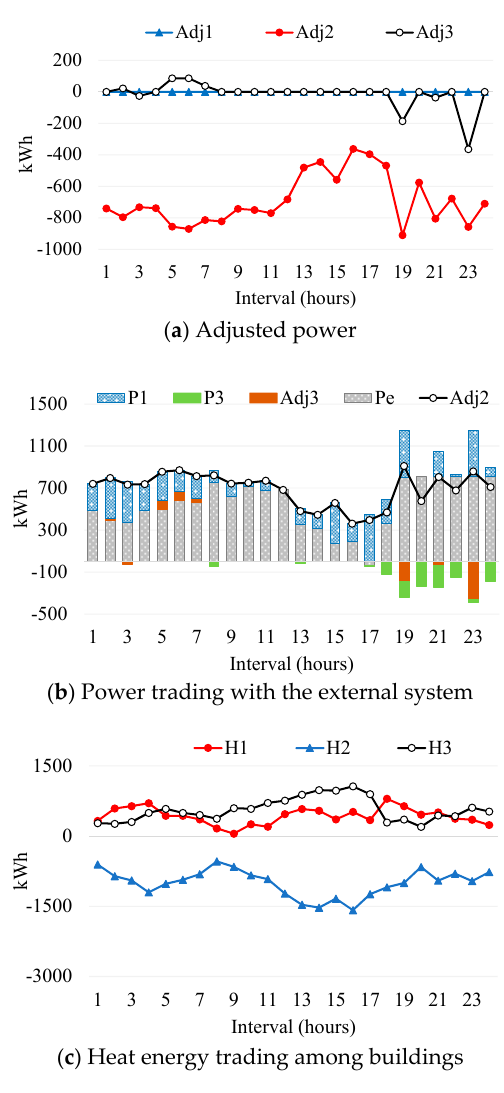
Figure 9. Adjustable power and energy trading in buildings during a weekday. Table 3. Saved cost with the proposed operation